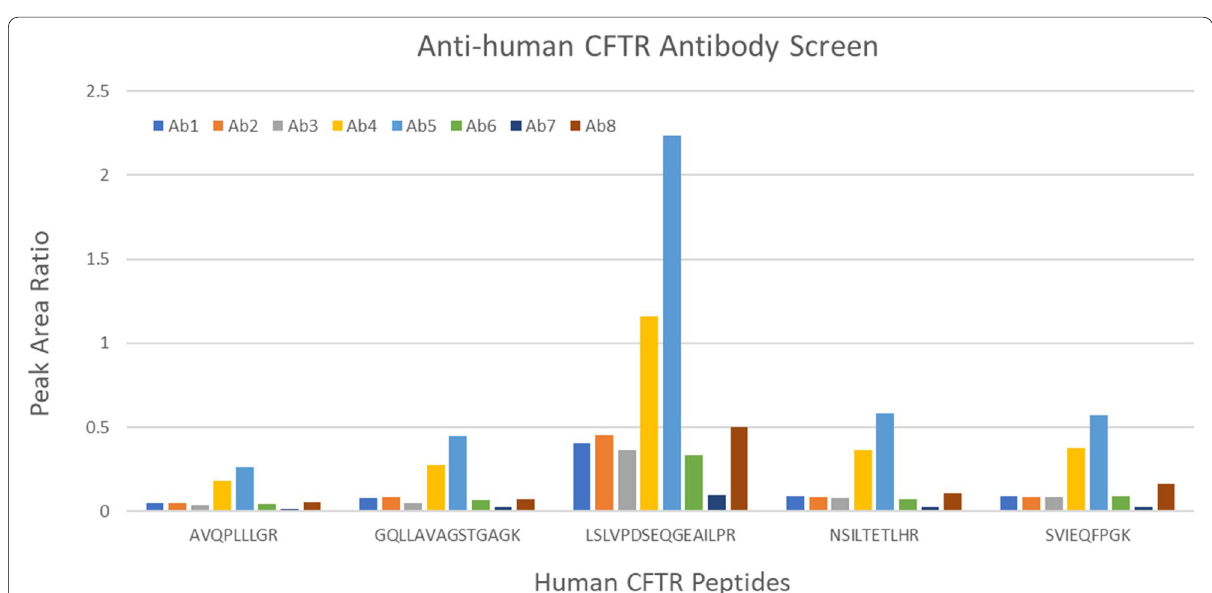
Fig. 5 Comparison of MS responses of five hCFTR peptides (AVQPLLLGR, GQLLAVAGSTGAGK, LSLVPDSEQGEAILPR, NSILNPINSIR, and SVIEQFPGK) generated by IP using 8 different anti-human CFTR antibodies. hCFTR protein (1 ng) spiked in mouse lung membrane protein extracts (25 mg lung tissue) was used as test sample. Protein G magnetic beads and un-biotinylated antibody were used for IP. Data were processed by skyline